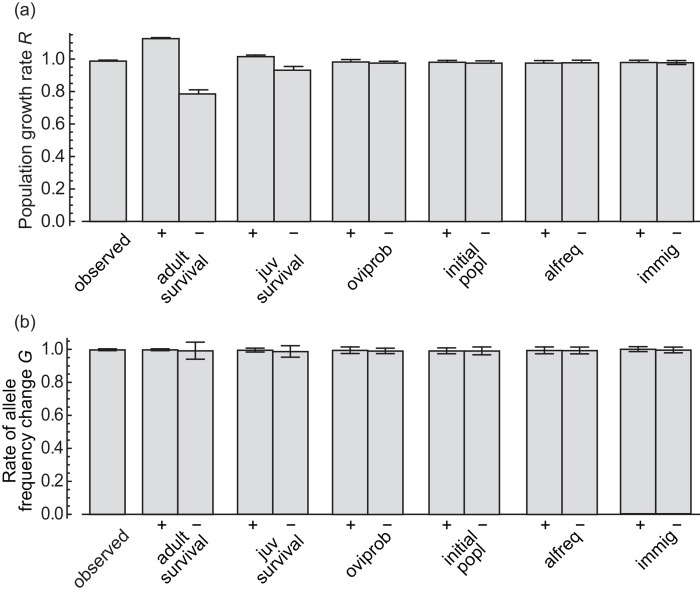
Change of butterfly population growth rate with 4 spatial attributes of T. arvense distribution that significantly affected butterfly population dynamics: “cover” (a), “dist” (b), “thdist” (c) and “shape” (d).Symbols represent different levels of “cover”, i.e., the proportion of habitat occupied by T. arvense to the total habitat occupied by the host plants; closed circle: <3%, open circle: <5%, triangle: <10%, diamond: <20%.